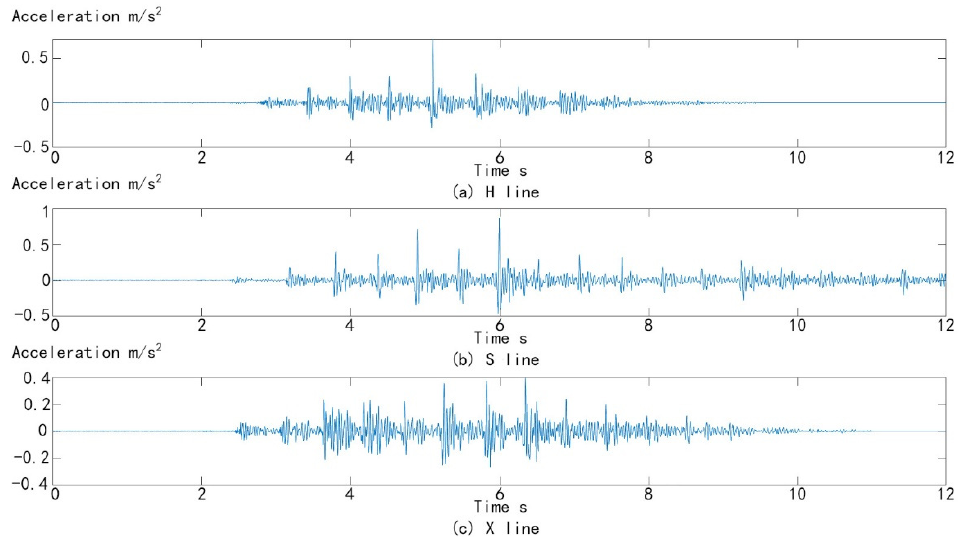
Table 5. Comparison between the measured and predicted deflection values under 1kN static load at the center of the T1